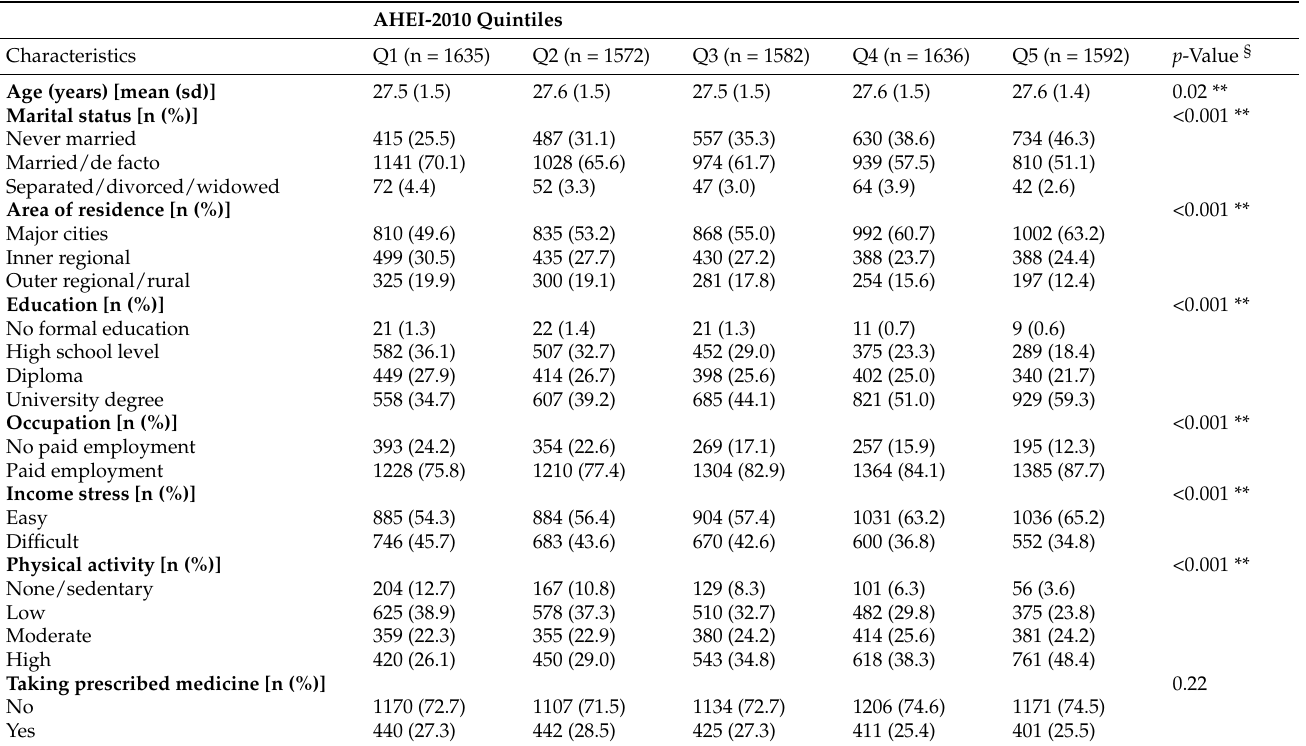
Table 1. Baseline characteristics of the sampled women (n = 8017; survey 3 in 2003) by quintiles of Alternative Healthy Eating